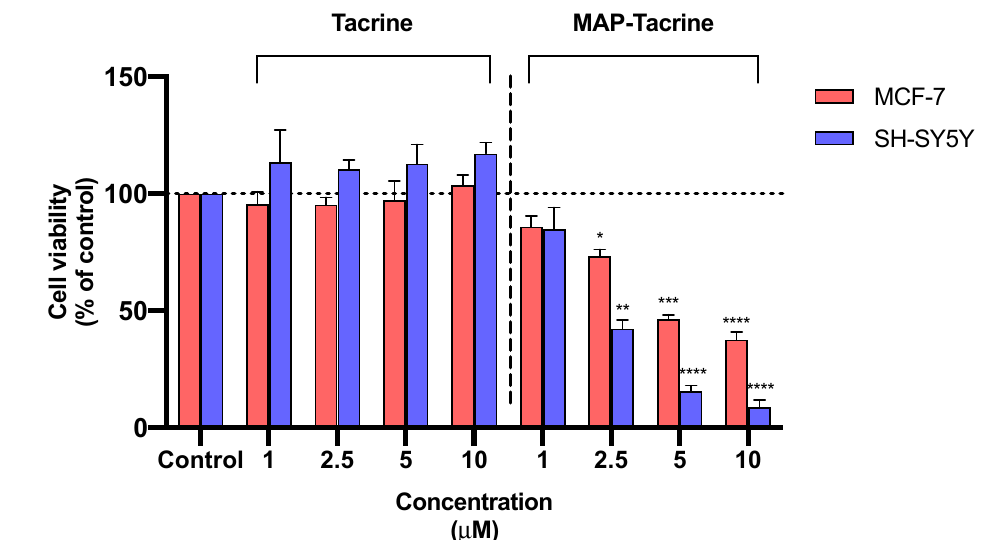
Figure 4. MCF-7 breast cancer and SH-SY5Y cell line cytotoxic effects of increasing concentrations of Tacrine, and Tacrine-MAP after a 24 h incubation. H 2 O was used in control. Significant differ- ences (ANOVA test, followed by the with Dunnett’s post hoc test): * p < 0.05, ** p < 0.01, *** p < 0.001 and **** p < 0.0001 vs. Control. The values represent mean ± SEM ( n = 3).